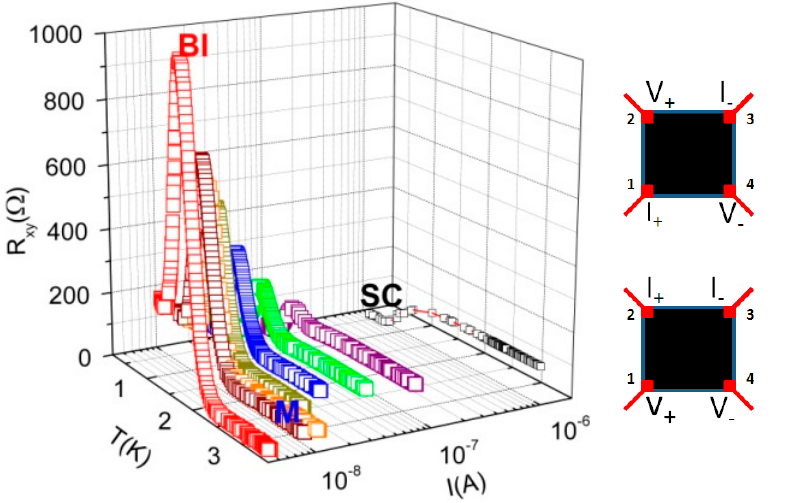
Figure 3. Evolution of metal-insulator-superconductor (SC) transition with a current variation. from 1 µ A down to 10 nA. The resistance shows various phases as current and temperature are varied. It is seen that as the bias current is reduced the bosonic insulator (BI) peak increases sharply but does not shift in position. The geometry for the transport property measurements is shown on the right.